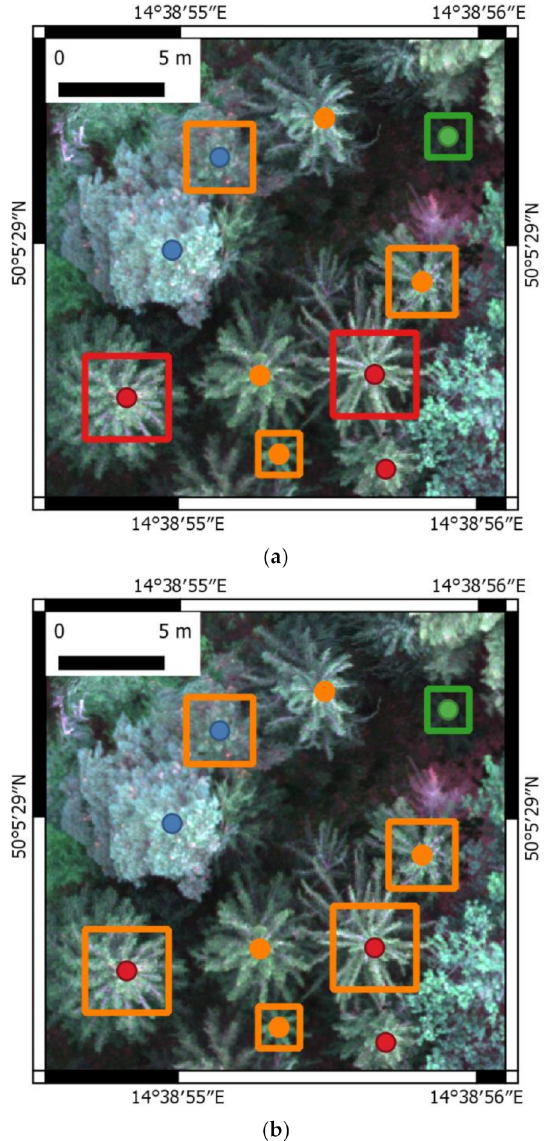
Figure 5. Illustration of classification results using test dataset: ( a ) Safaugu 4c3b; ( b ) RF 4c3b. Ground truth data are represented by points. Model predictions are represented by squares. Pines are highlighted in blue. Sbbd spruces are highlighted in red. Sbbg spruces are highlighted in orange. Sh spruces are highlighted in